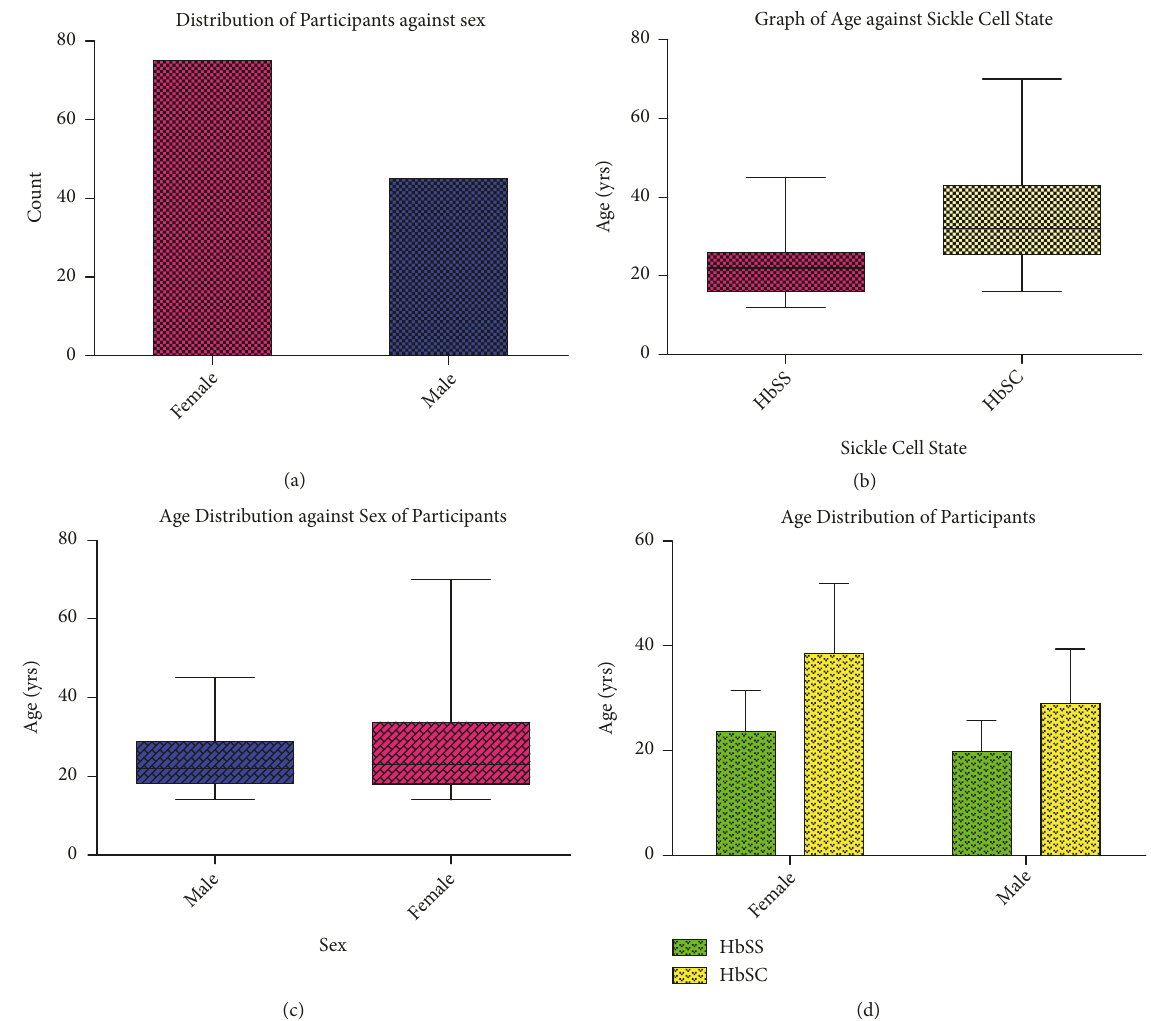
Figure 1: The figure shows the age and gender distribution of the participants. Majority (62.5%) of the participants were females.